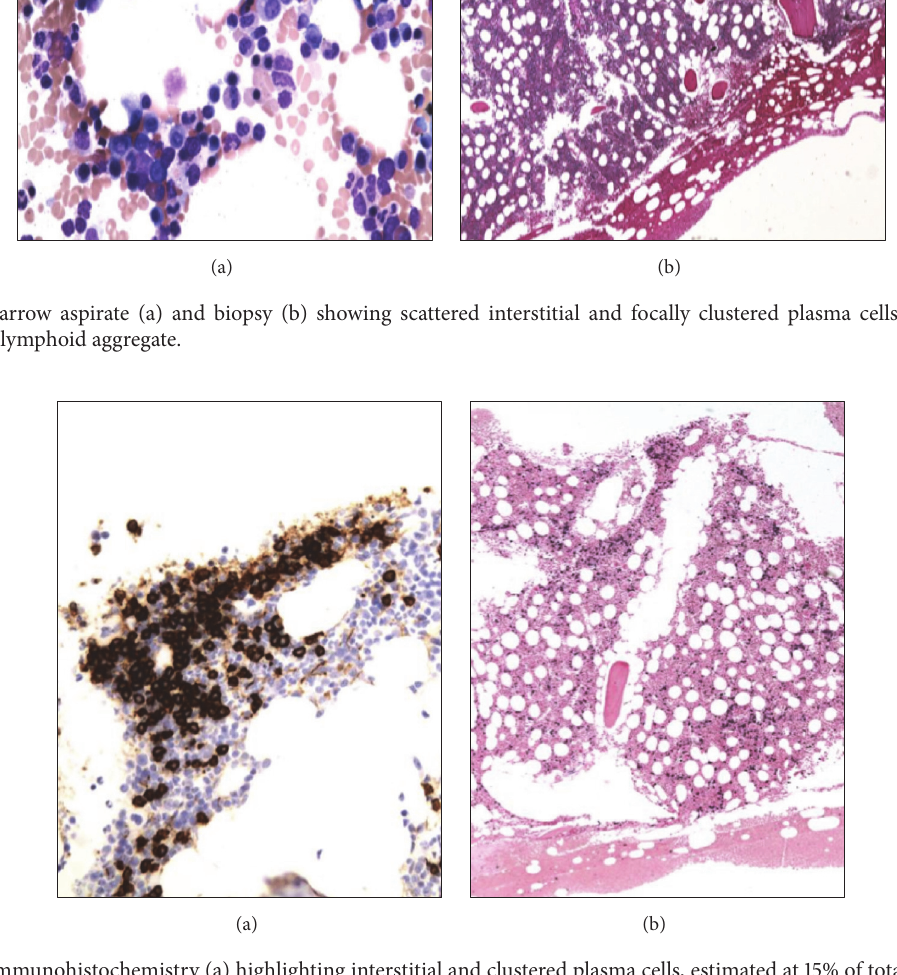
Figure 2: CD138 immunohistochemistry (a) highlighting interstitial and clustered plasma cells, estimated at 15% of total cells, with lambda light chain restriction by in situ hybridization